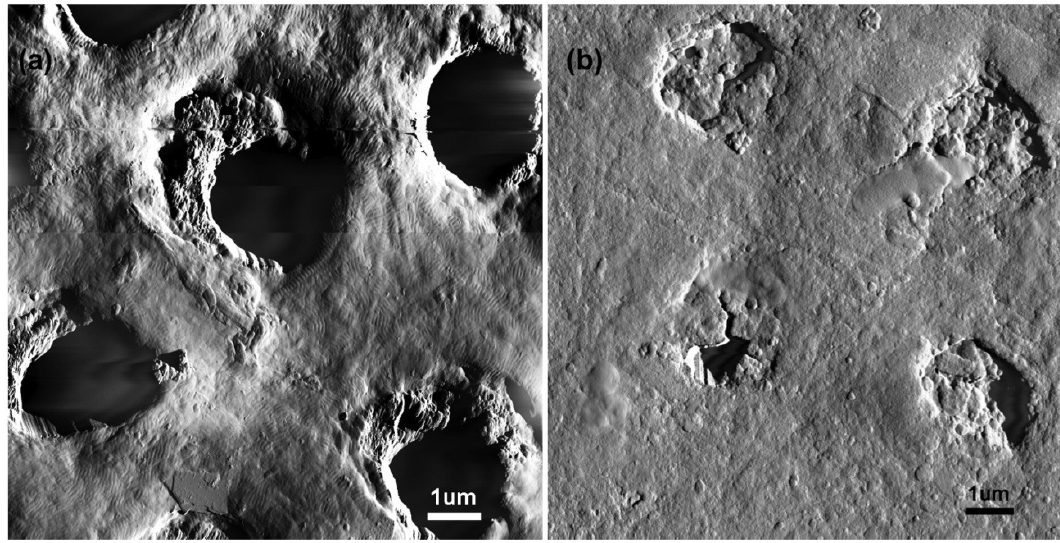
Figure 3. ( a ) Inverted AFM amplitude images of untreated dentine surface with exposed and opened tubules. Visible helical structures can be seen on surface. ( b ) Dentine surface after ProClude prophylaxis paste treatment. Helical structures are absent from surface and tubules are occluded, suggesting the treatment resulted in a protective layer over the exposed dentine surface and sealing of the open tubules. Reprinted with permission from [19]. Copyright 2009Yes Group,